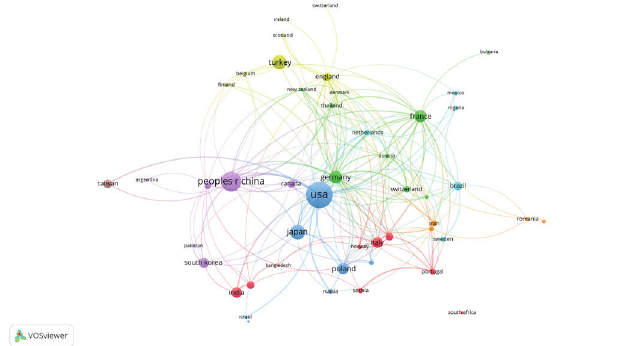
Figure 4 - Keyword network in research field Figure 5 - Collaborative country network in research